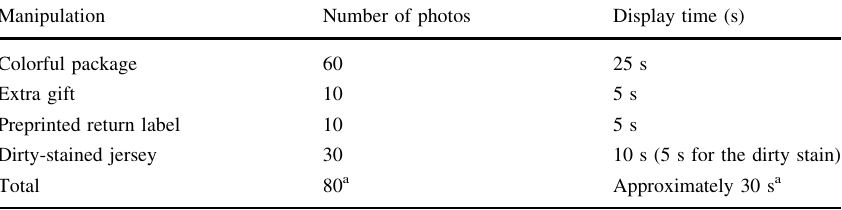
Table 1 Details of the stop-motion animation video Manipulation Number of photos Display time (s) Colorful